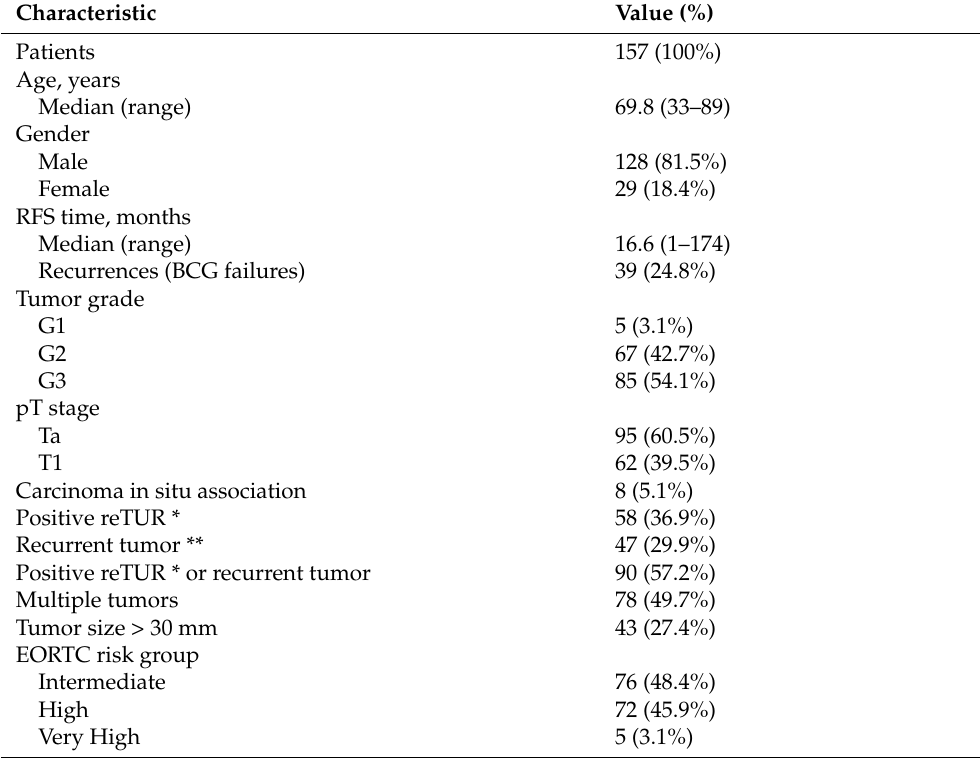
Table 1. Summary of clinical and pathologic